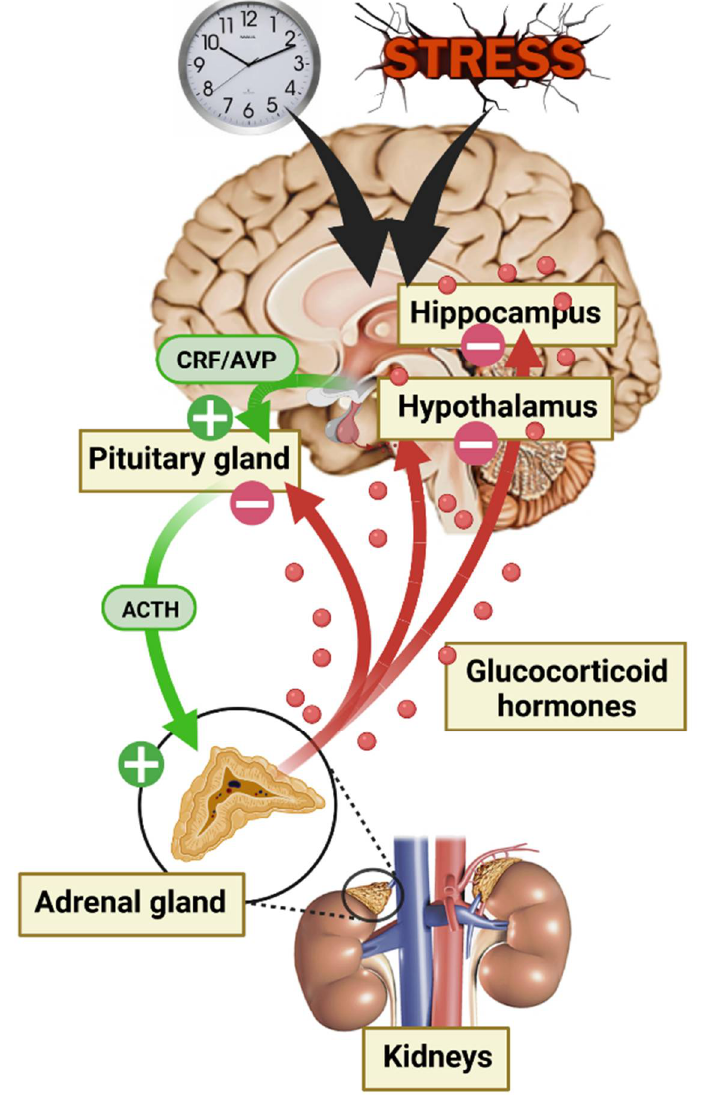
Figure 2. Diagram of hypothalamic–pituitary–adrenal (HPA) axis activation during the circadian cycle and in response to stress.